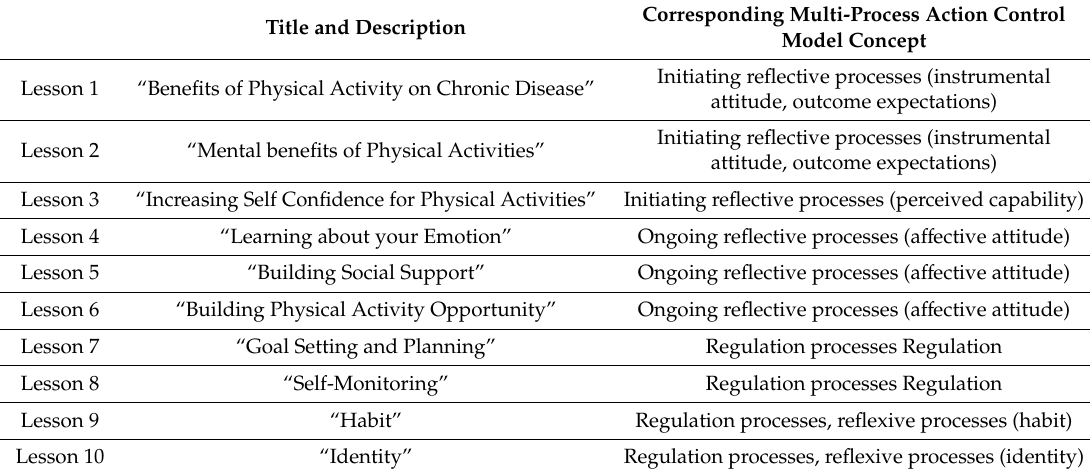
Table 1. Overview of online platform lesson content linked to the theoretical / behavioral concepts used in this